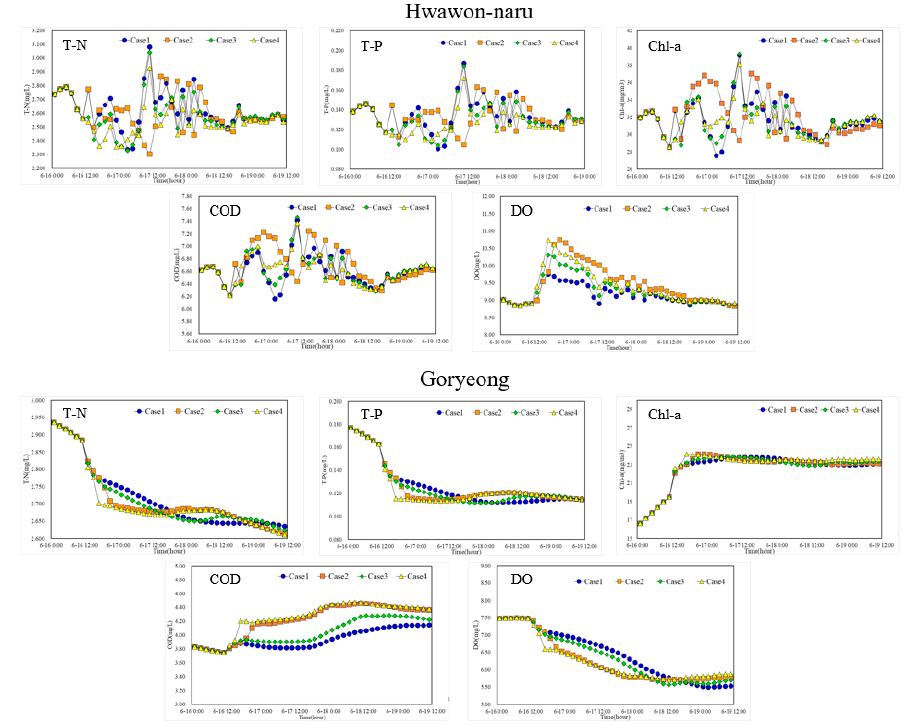
Figure 7. Scenario Comparison Results .